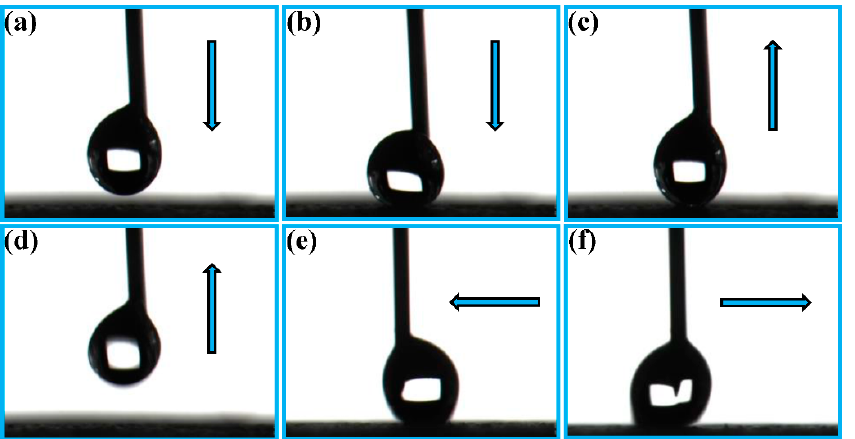
Figure 5. Water droplet adhesion test. Vertical droplet test ( a – d ) and droplet pinning test ( e , f ). Volume of a water droplet (5 µL).